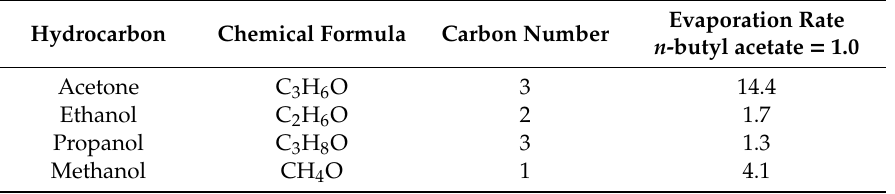
Figure 11. Selectivity of the chitosan-PEG sensing layer to 5 ppm acetone vapor compared to humidity, 5 ppm propanol, 5 ppm methanol, and 5 ppm ethanol vapors. Table 4. Properties of the analytes extracted from a previous work [42].